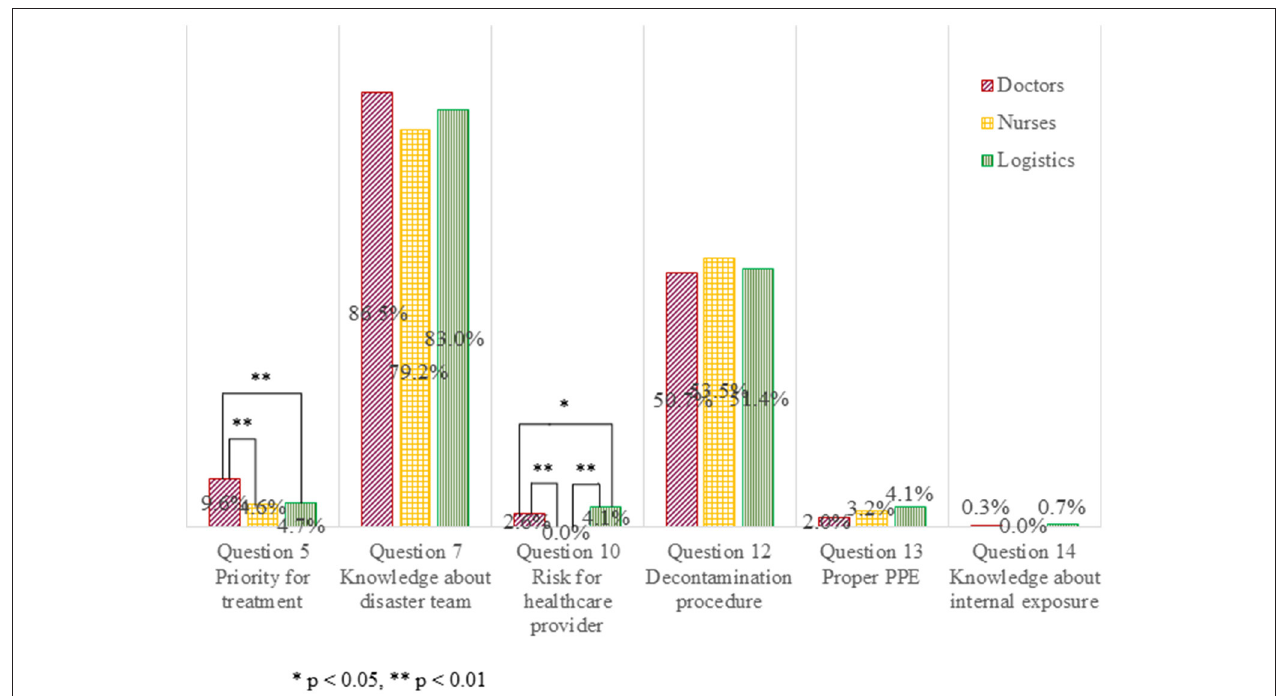
FIGURE 4 | Accuracy rate of responses about the respondent’s knowledge of the medical practice and the risk.